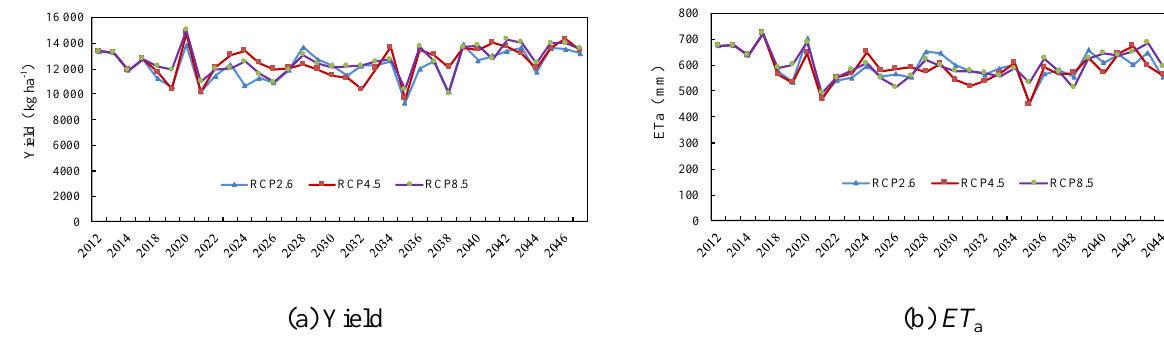
Figure 4. Temporal variations of corn yield and ET a in the Gaotai area under RCP scenarios.